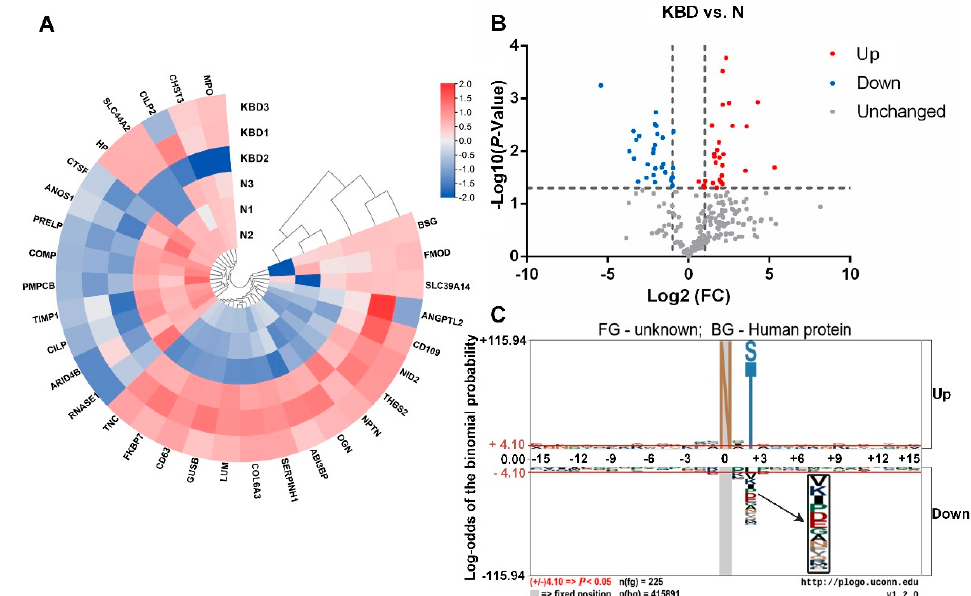
Figure 3. Heatmap, volcanic plot, and motif analysis in KBD vs. N. ( A ) Heatmap of differentially expressed N-glycoproteins of knee cartilage in KBD vs. N. Circular heatmap obviously classified